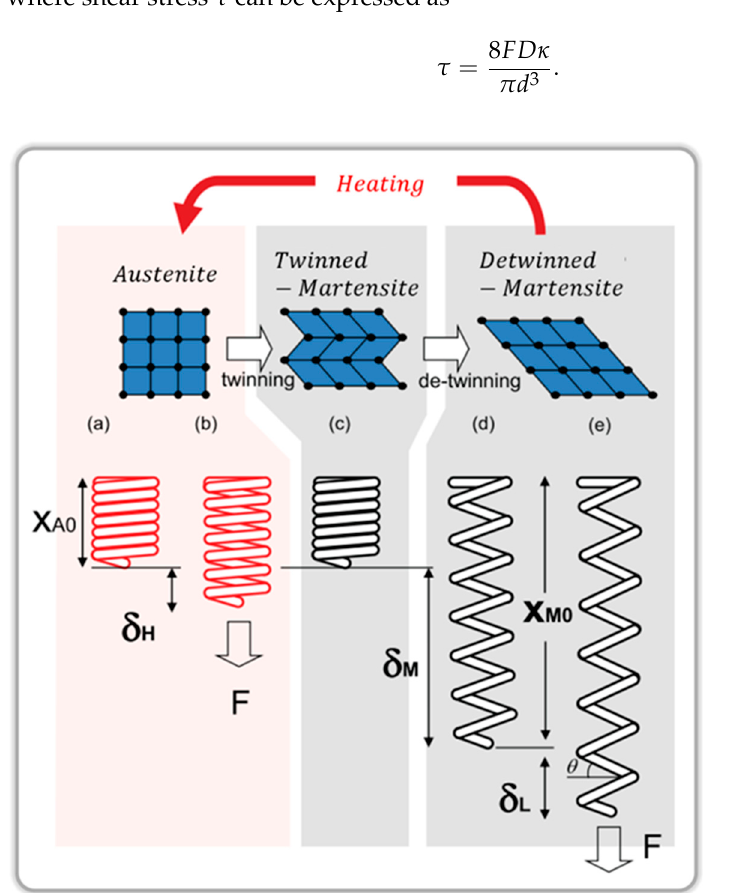
Figure 7. Five characteristic representative states of NiTi coil spring actuator. ( a ) Complete austenite phase without load, ( b ) complete austenite phase with load, ( c ) twinned martensite phase without load, ( d ) complete detwinned martensite phase without load, and ( e ) complete detwinned martensite phase with load. Adapted with permission from [43], IEEE, 2013.